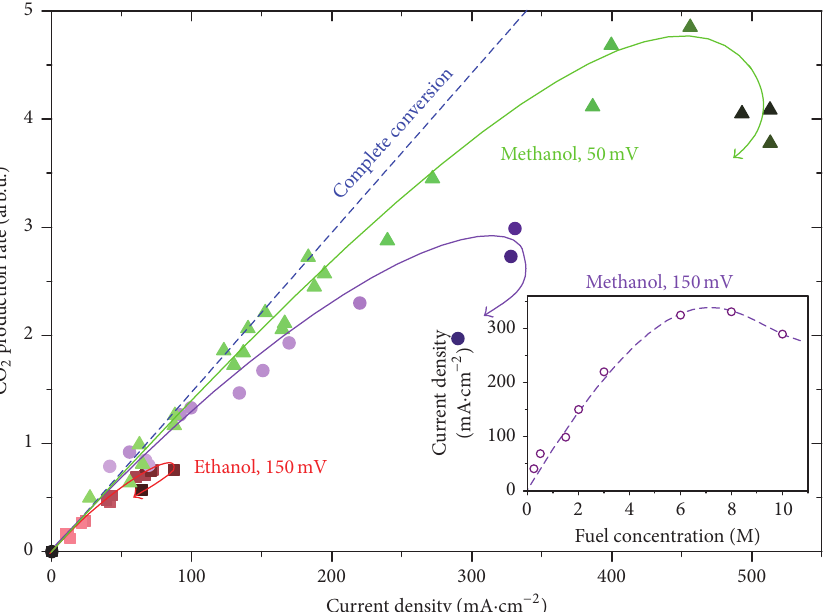
Figure 4: Correlation between current density generated by fuel cell and CO 2 production at its anode for various fuel concentrations between 0.25 and 10M (methanol) and 0.25 and 14M (ethanol); total flow rate was 25 sccm. The color intensity of experimental points reflects the fuel density. Blue dashed line represents complete conversion of alcohol molecule to CO 2 . Inset: current density of the methanol-fed FC at 150mV as a function of fuel